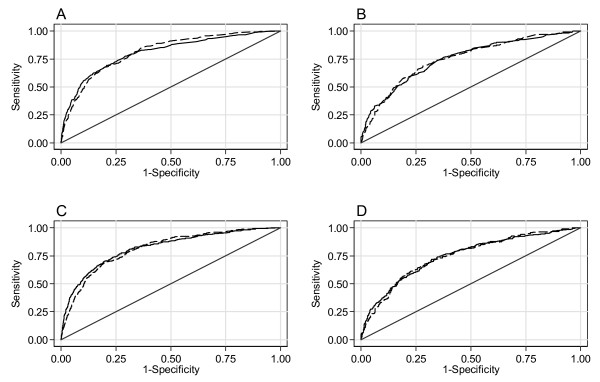
Yersinia whole-genome phylogeny. The phylogeny of the Yersinia genus was constructed from a dataset of 681 concatenated, conserved protein sequences using the Neighbor-Joining (NJ) algorithm implemented by PHYLIP [51]. The tree was rooted using E. coli. The scale measures number of substitutions per residue. Tree topologies computed using maximum likelihood and parsimony estimates are identical with each other and the NJ tree (Additional file 20). The only branches not supported in more than 99% of the 1,000 bootstrap replicates using both methods are marked with asterisks. Both these branches were supported by >57% of replicates.